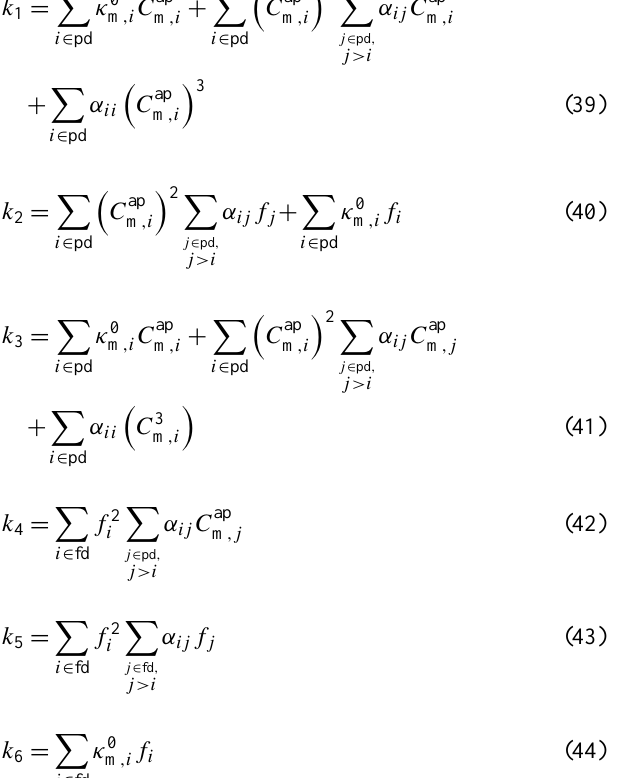
Figure 6e and f show the hygroscopicity parameter κ m as function of water activity. The data points were obtained by inserting the corresponding pairs of G m − κ m values from Fig. 6c and d in Eq. (10). The model lines were obtained by